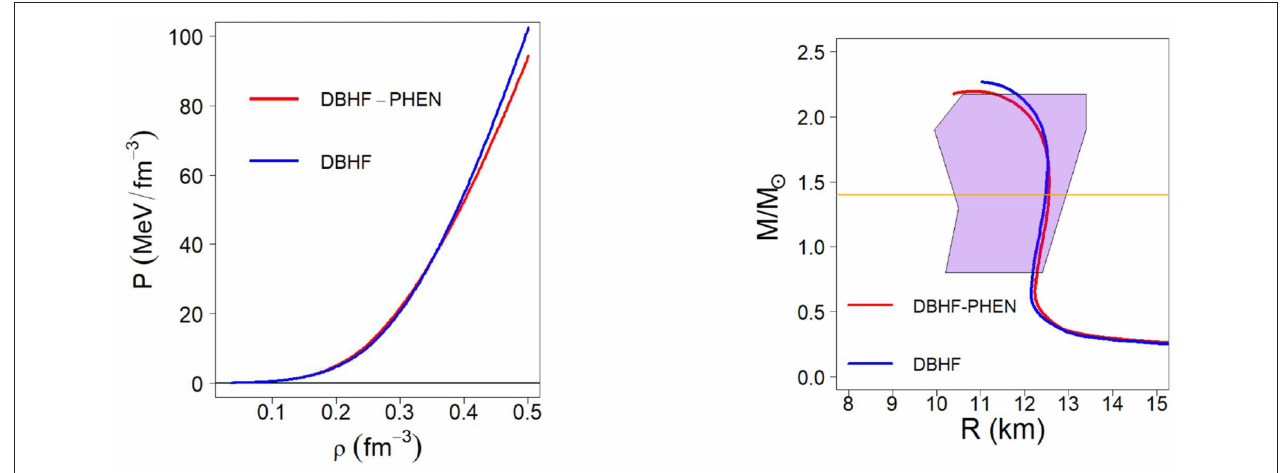
FIGURE 14 | (Left) Pressure in β -stable matter as a function of density obtained with the Bonn B meson-exchange potential and the DBHF approach to nuclear and neutron matter. The blue and the red curves are obtained using the phenomenological EoS for SNM or the microscopic one, respectively. (Right) The mass vs. radius relation for a neutron star obtained with the DBHF calculations as explained in the text. As before, the lavender shaded area is the constraint from Steiner et al. [